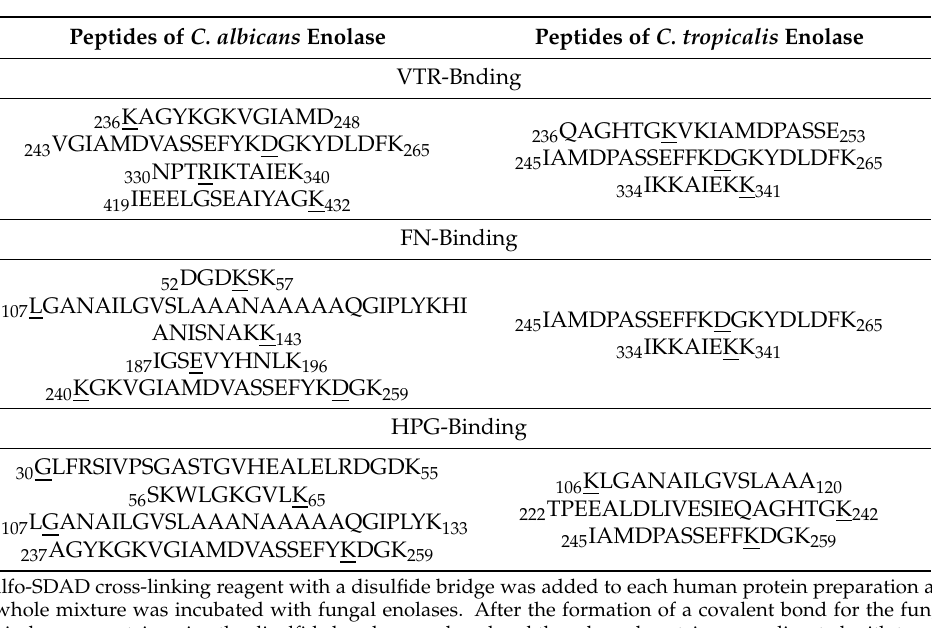
Table 2. Mass spectrometry identification of C. albicans and C. tropicalis enolase peptides involved in the interaction with VTR, FN and